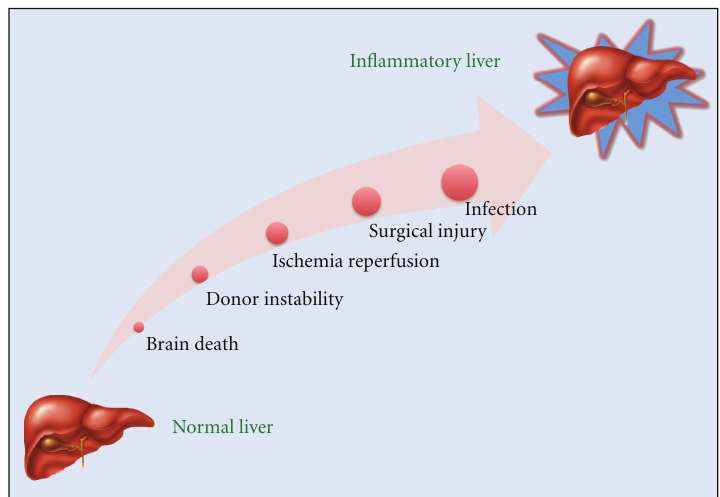
Figure 2: Liver injury during transplantation can convert an immunologically quiescent organ to an inflammatory organ that promotes acute